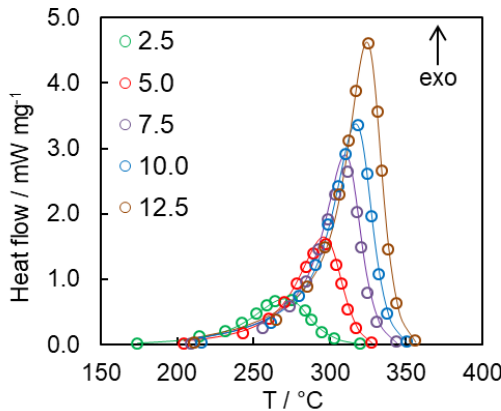
Figure 11. Comparison of the experimental heat flow curves (circles) with the calculated ones (lines) for bulk cyanate ester polymerization at different heating rates.